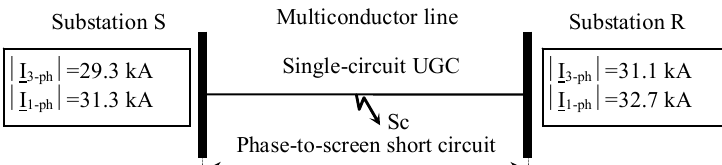
Figure 1. Single-circuit faulted underground insulated cables (UGC) supplied at both